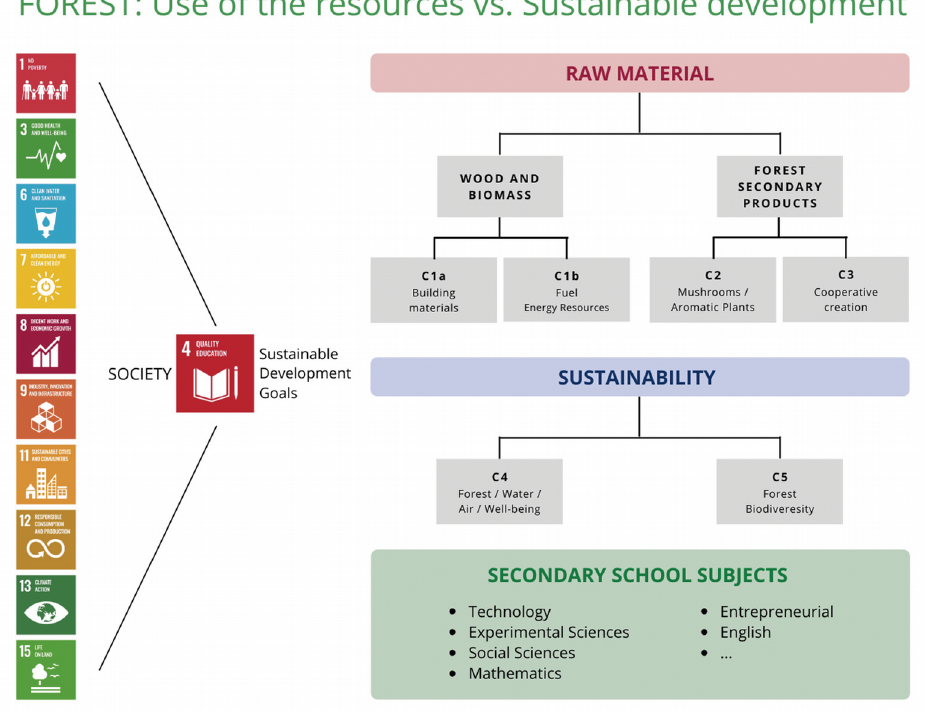
Figure 8. Diagram for applying OSS to forest studies. Original